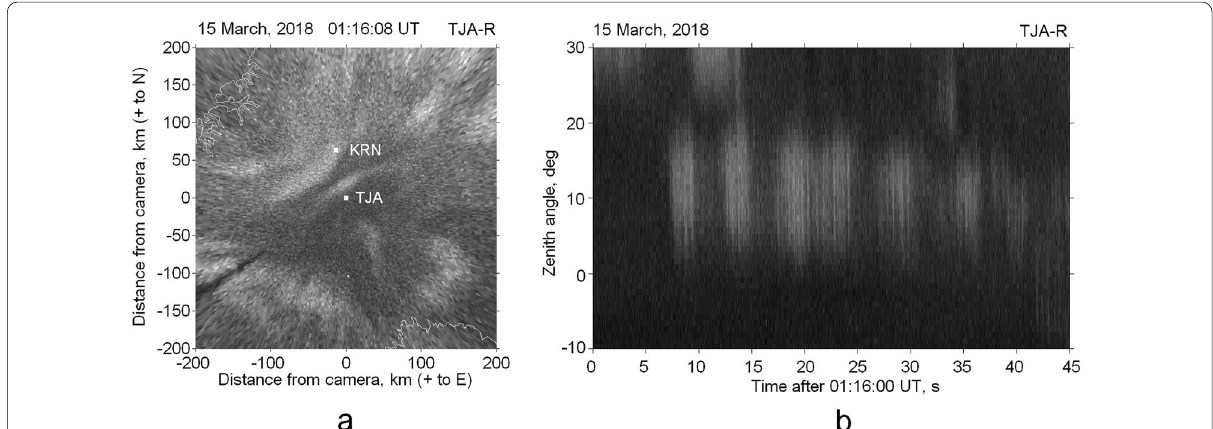
Fig. 1 a Location of pulsating (zenith) arc relative to the KRN and TJA observatories (white squares). b Keogram showing the temporal variation in auroral brightness sampled along the south to north cross section. A series of bright patches on the keogram reveals the main pulsations of the arc intensity, and vertical strips inside the patches are the signature of quicker